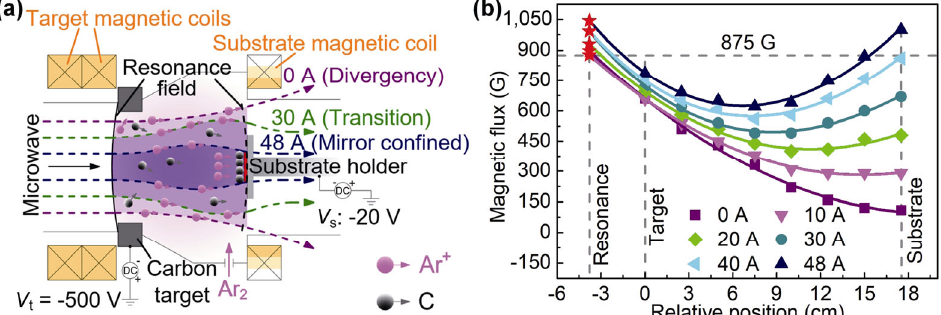
Fig. 1 (a) Schematic of sample preparation and (b) transformation of the magnetic induction lines while regulating the substrate magnetic coil